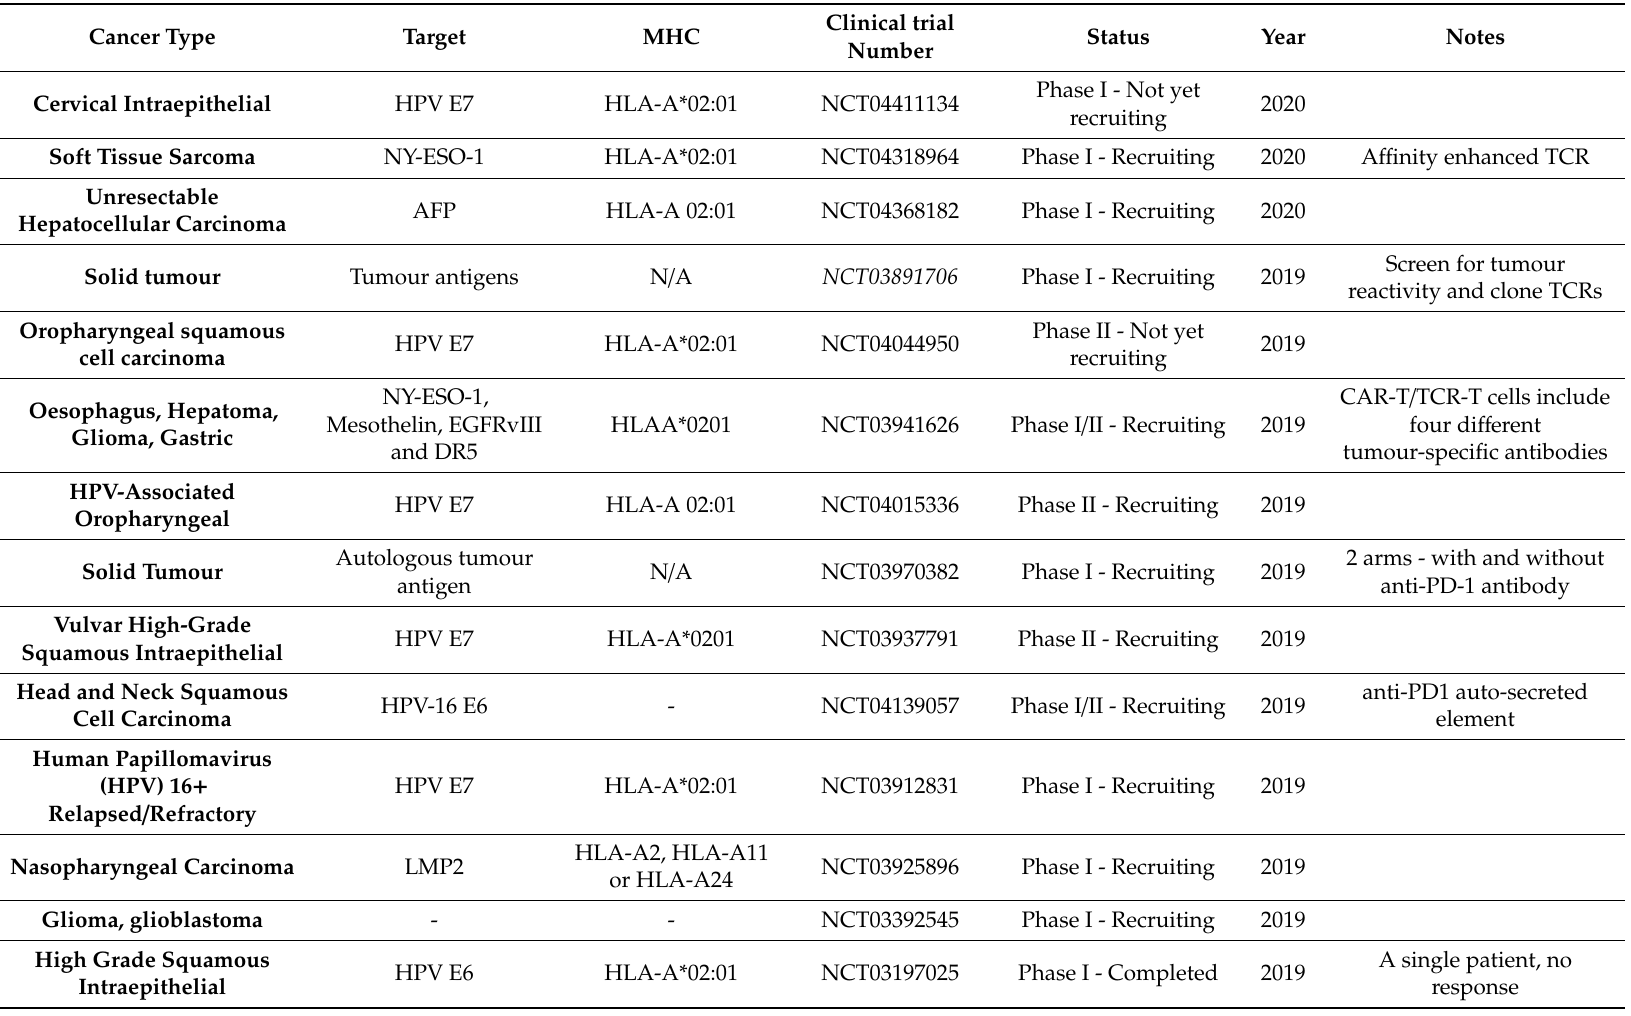
Table 1. Clinical trials involving TCR-T